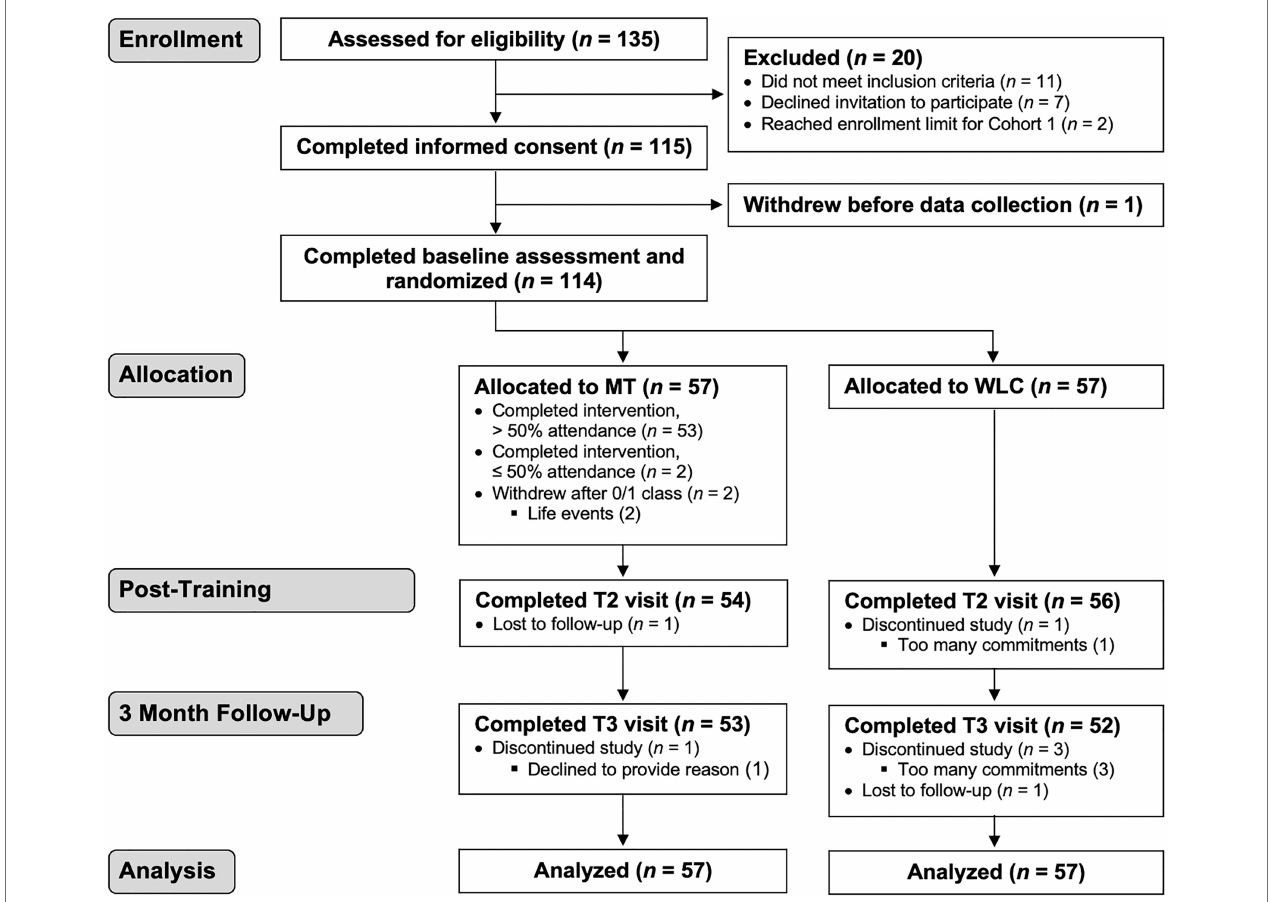
FIGURE 1 | CONSORT diagram. Primary intent-to-treat analysis includes all participants with baseline data collection ( n = 114). MT, mindfulness training and WLC, waitlist